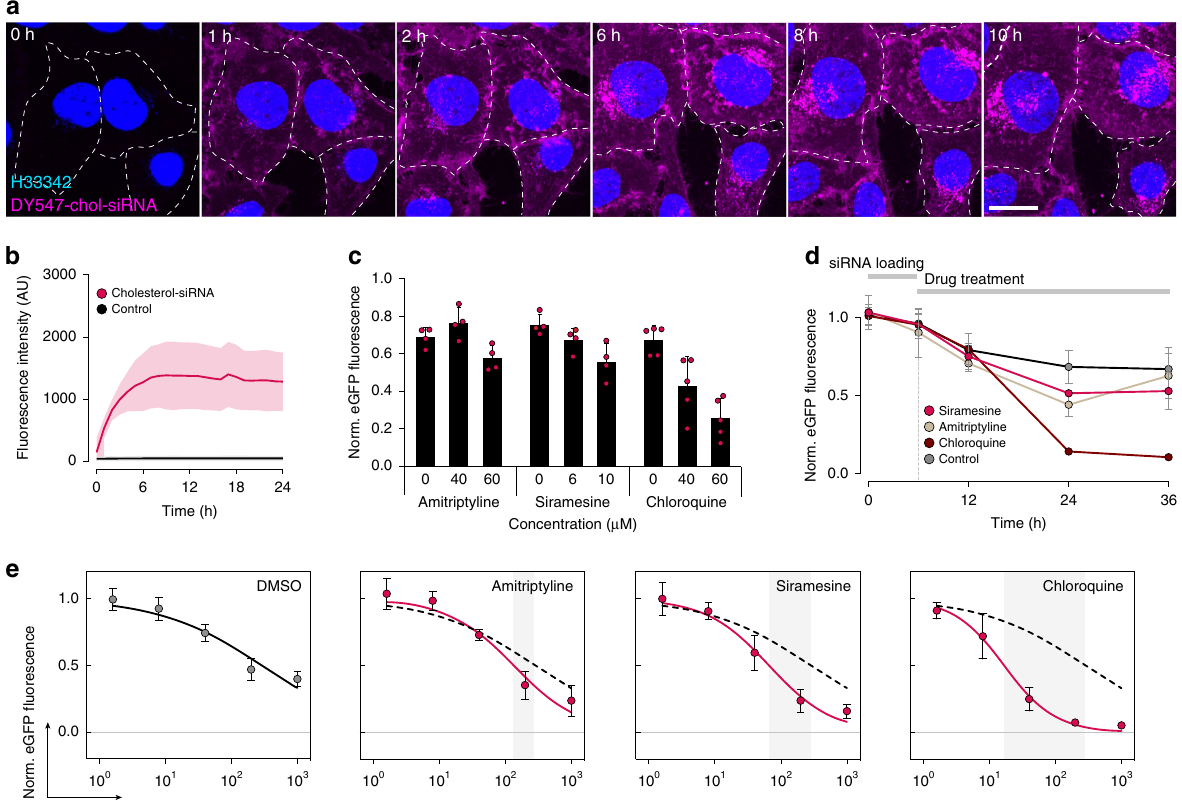
Fig. 2 Membrane-destabilizing drugs improve chol-siRNA-mediated knockdown. a Chol-siRNA internalization was monitored for 24 h in HeLa cells using confocal microscopy. Representative images from two independent experiments. Scale bar, 20 μ m. b Quanti fi cation of chol-siRNA internalization from confocal microscopy images. Lines are means, shades are s.d. N = 3 independent experiments. c HeLa-d1-eGFP cells were incubated with 40 nM